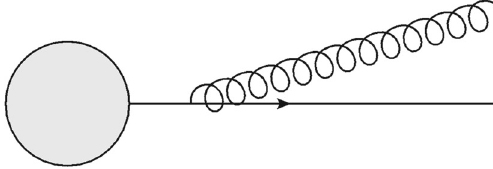
Fig. 5 The zeroth order in opacity contribution to the amplitude for next-to-leading order momentum